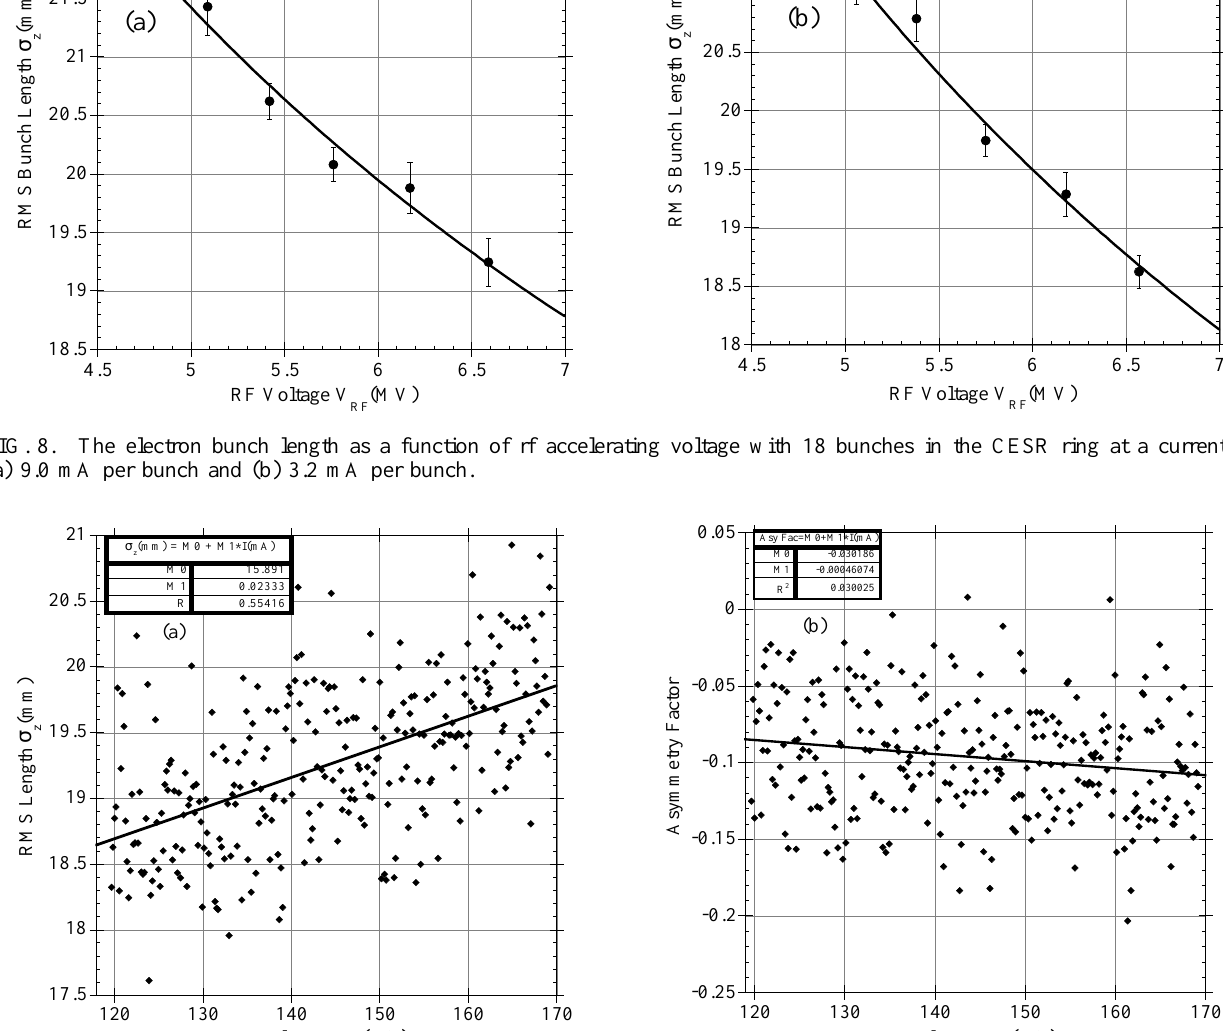
train was measured during colliding beams. The results are plotted in Figs. 11(a) and 11(b). Each data point is the mean and rms error of 20 streak camera pictures. The bunch length for the first bunch in the train is